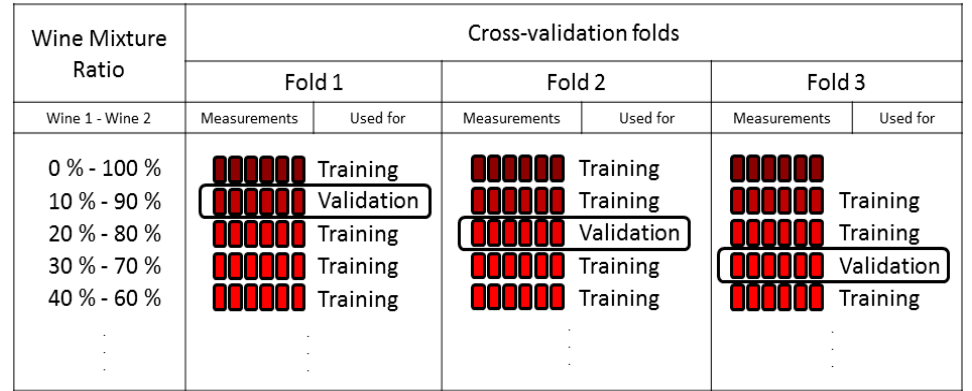
Figure 1. Scheme of the experimental setup.